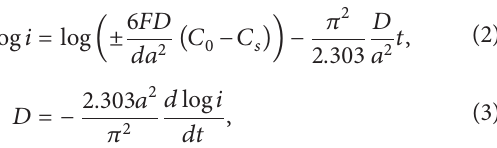
Figure 4: Dynamics testing of milled La 2 Mg 17 + 150wt% Ni + 𝑦 wt% TiF 3 ( 𝑦 = 0,3, 5 ) composite materials: (a) Tafel polarization curves 50% DOD; (b) semilogarithmic curves of anodic current versus time